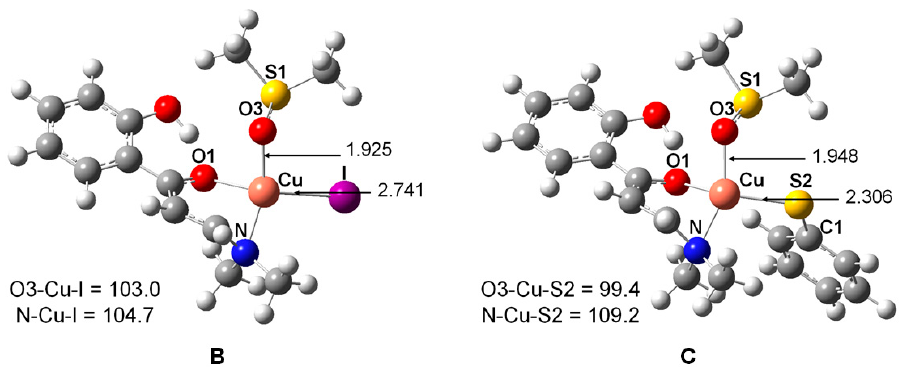
Figure 2. Optimized structures for intermediates B and C .